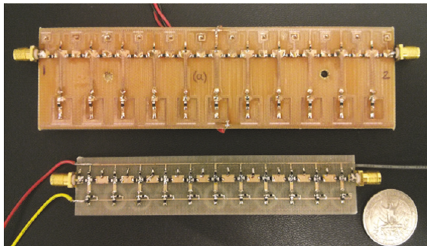
Figure 13: Comparison between the conventional and the proposed miniaturized reconfigurable LWA. Both antennas were designed by cascading 𝑁 = 11 unit cells. The former occupies an area of 56 cm 2 while the latter occupies an area of 26.5 cm 2 .